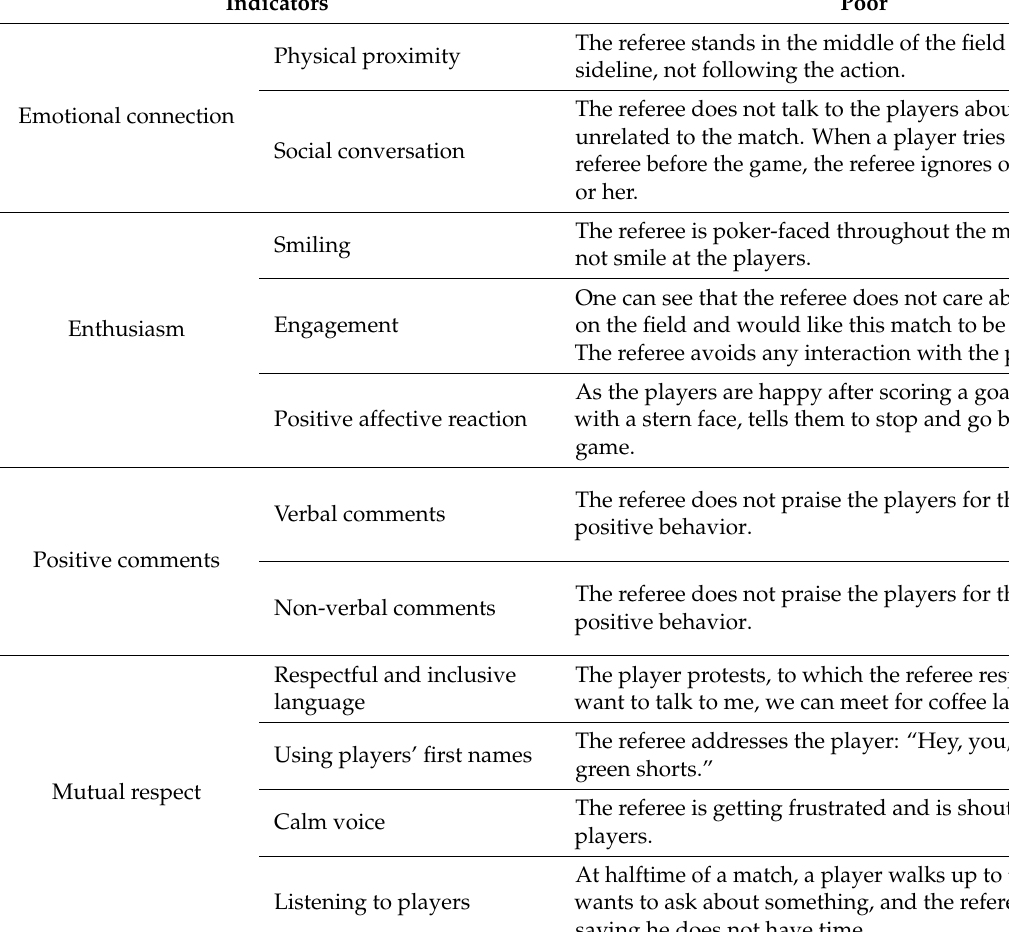
Table 2. Examples of low and high quality of referee–player interactions in the dimension of building a positive climate . Indicators Poor